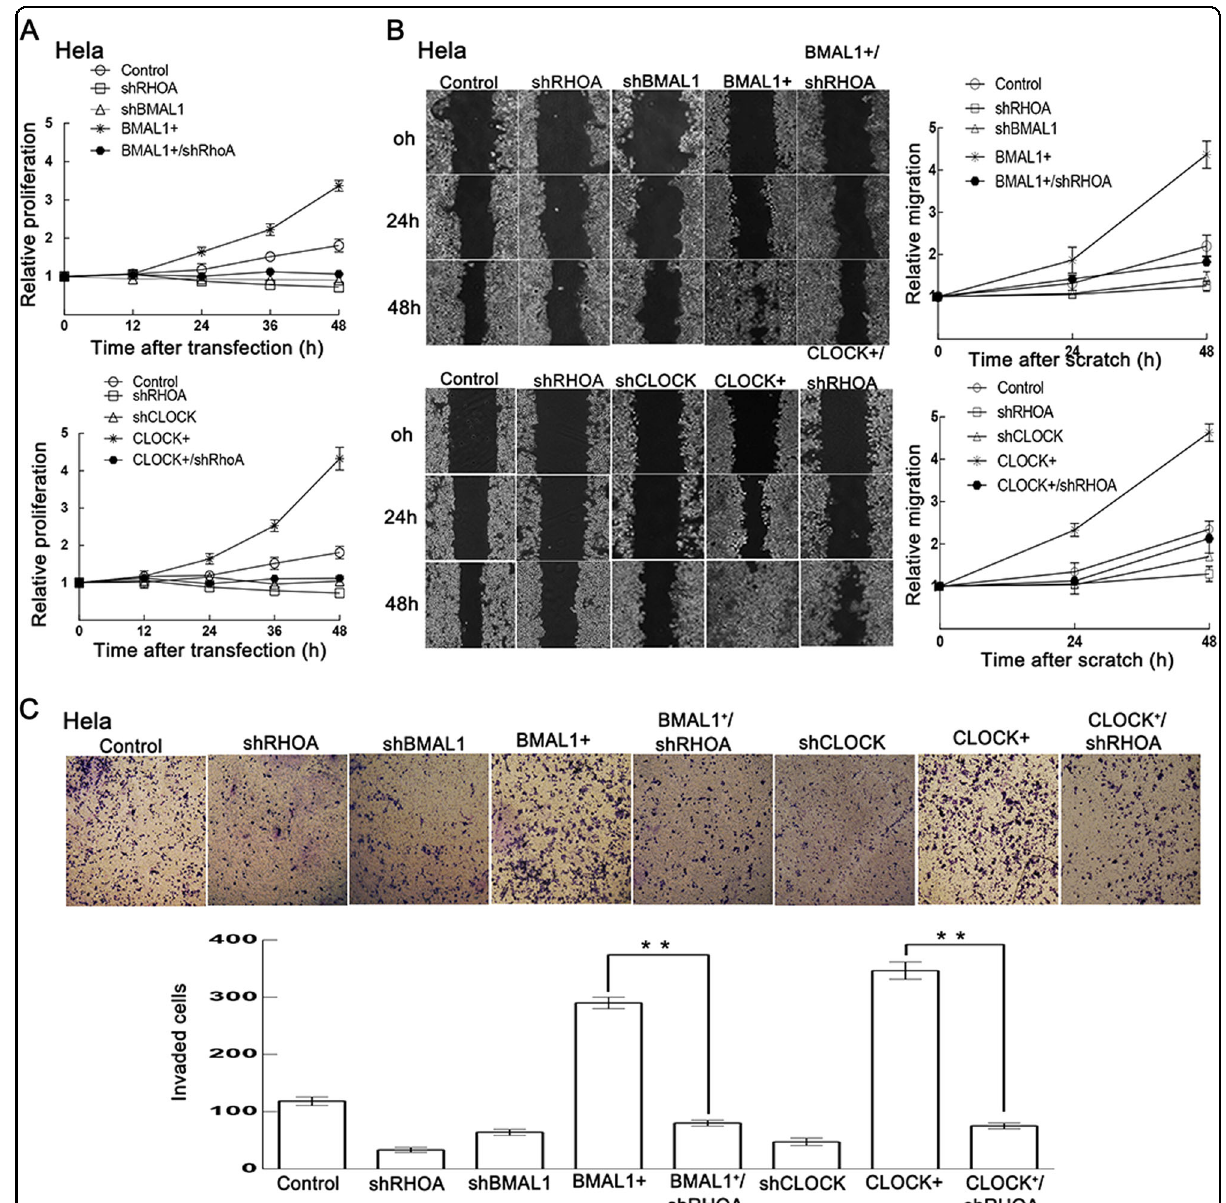
Fig. 7 CLOCK and BMAL1 promote cell proliferation, migration, and invasion. a The cell viability of HeLa cells was determined by Cell Counting Kit-8 assay after plasmid transfection. The results were normalized to the control group (mean± SD, n = 3). b Representative pictures of the scratch wound healing assay. During a 48-h wound closure assay, pictures were taken every 24 h using a time-lapse microscope. Representative pictures at 0, 24, and 48 h are shown. The distance of the wound was measured, and two line charts were used to display the width of the wound over time. Data were analyzed using a t test ( n = 3) and presented as the mean ± sd. c Representative microscopic images of cells that migrated through the transwell in the migration assay. After cell migration and staining with crystal violet, pictures of the migrated cells (purple stained) were taken using a microscope. ** p <